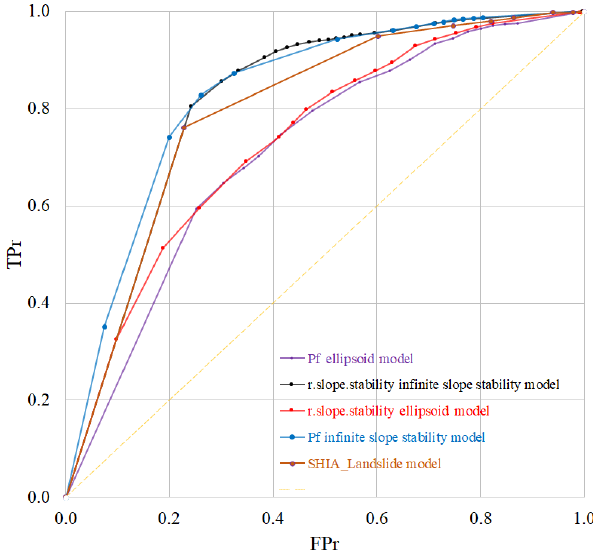
Figure 5. ROC curve models, r.slope.stability (infinite slope stability model) deterministic curve (0.83) and P f (0.82) for r.slope.stability (ellipsoid-based model) deterministic curve (0.73) and P f (0.71), SHIA_Landslide model